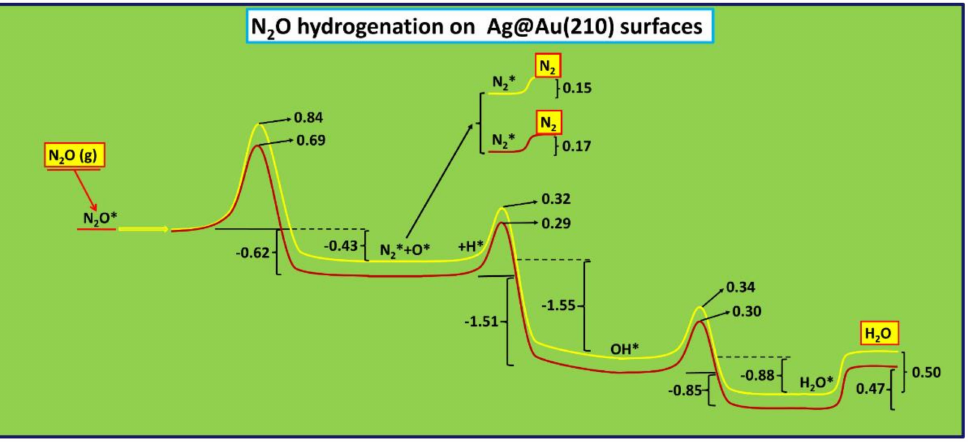
Figure 5. Comparison of the N 2 O hydrogenation reaction profiles on Ag@Au(210) (highlighted in yellow) and Ag 2 @Au(210) (highlighted in red) surfaces. Activation and reaction energies are given in